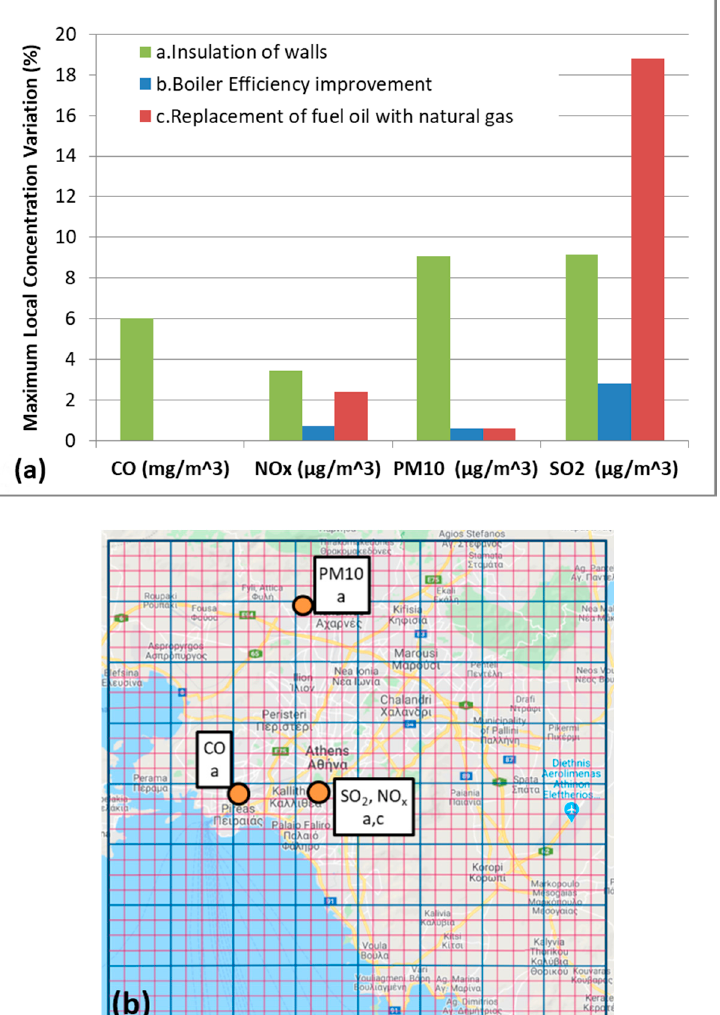
Figure 9. ( a ) Maximum reduction of local concentration values, for implementation of the three energy efficiency scenarios and ( b ) locations where notable maximum local reductions occur with respective pollutant and scenario noted next to each location. (map is modified from GoogleMaps).